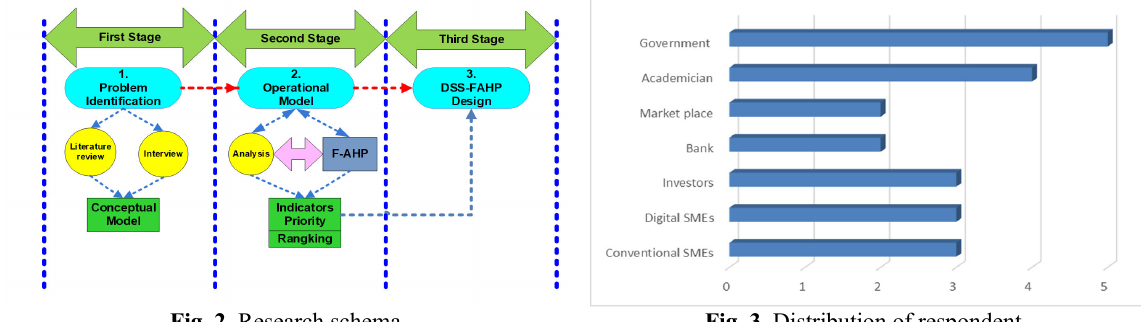
Fig. 2. Research schema Fig. 3. Distribution of